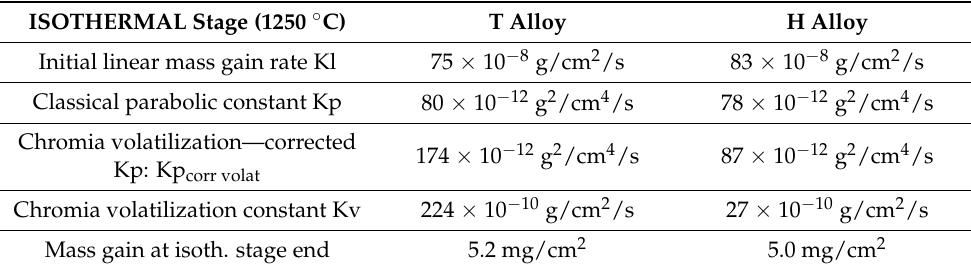
Table 3. Temperatures of start and end of melting and solidification (DTA at +5 and − 5 K min − 1 ); estimation of the solidus and liquidus temperatures for the two alloys.